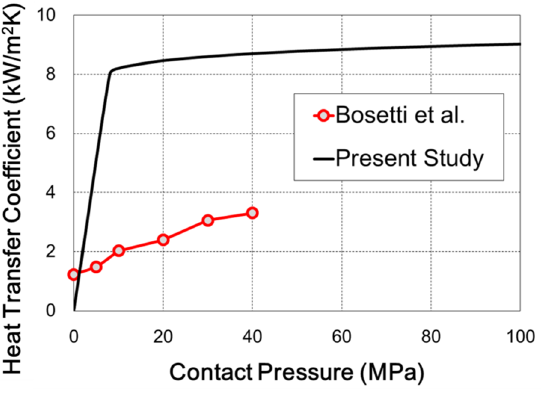
Figure 11. The comparison of heat transfer coefficient between the present study and Bosetti et al.